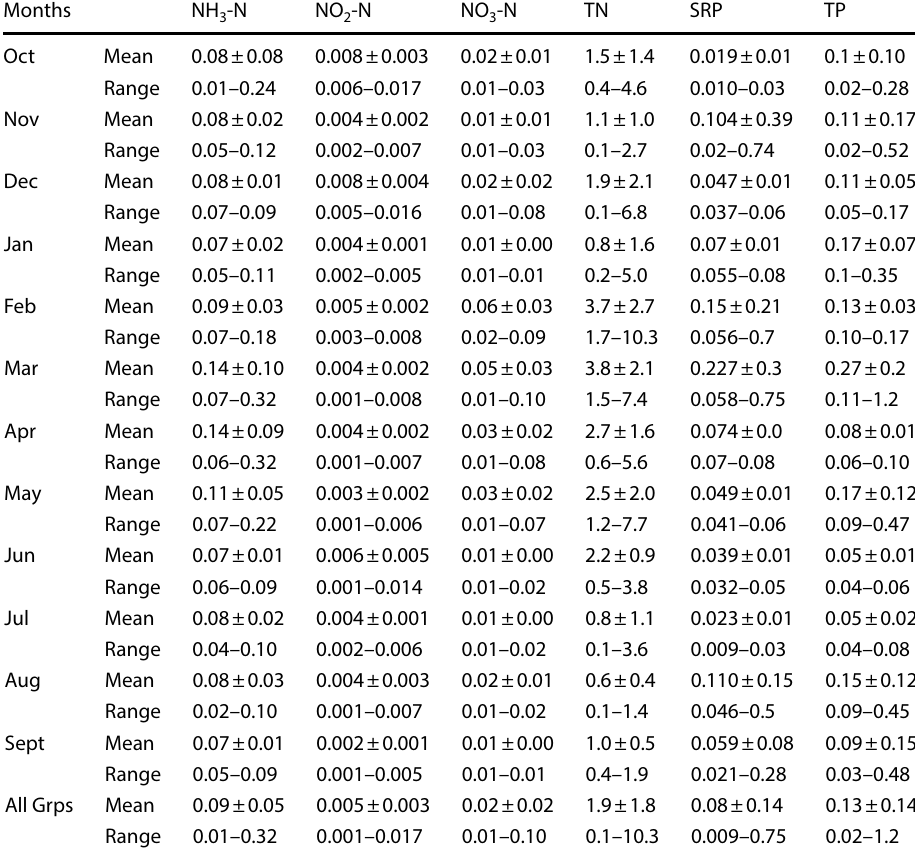
Table 6 Mean ± SD of nutrient concentration in the different sampling months ( n =